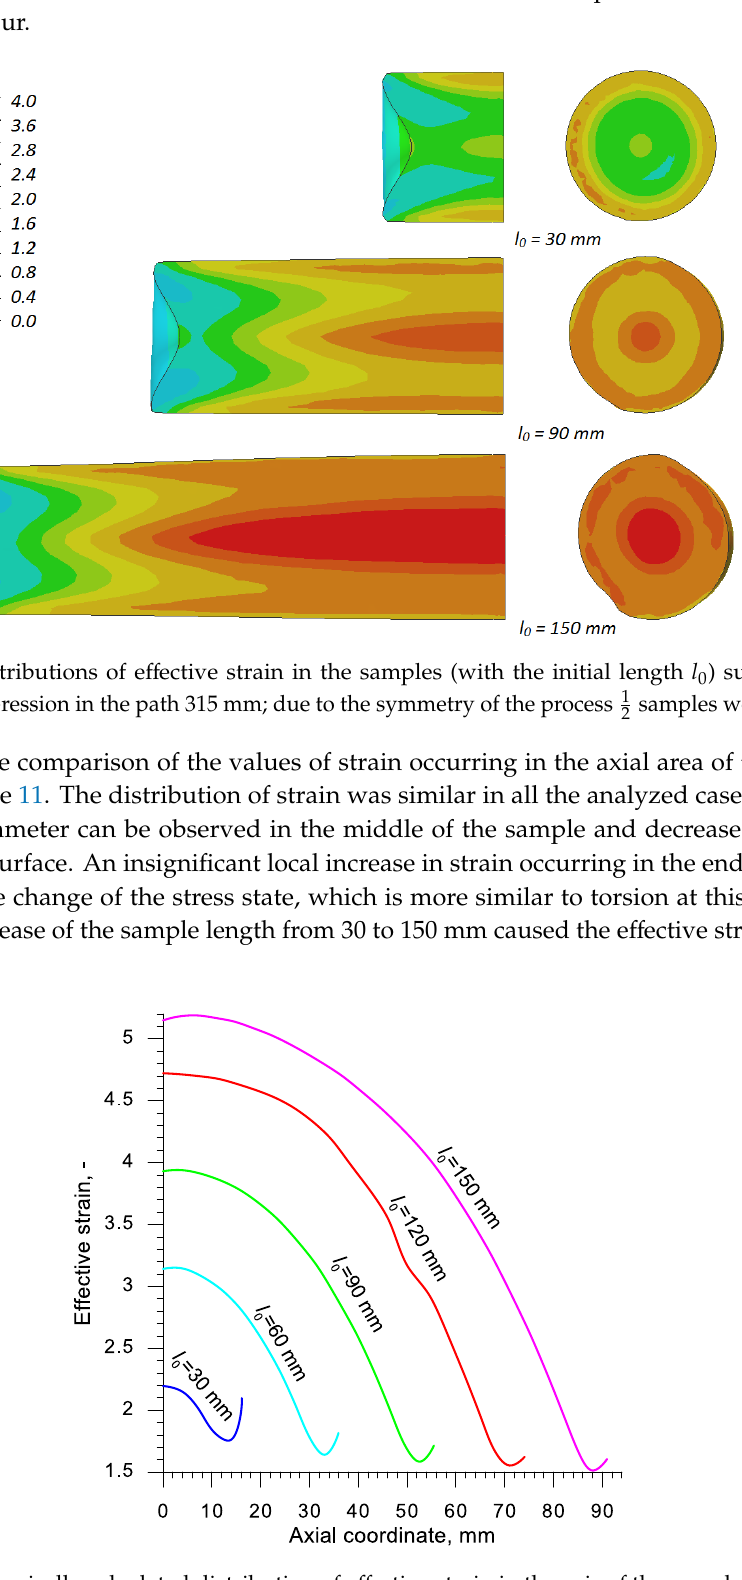
Figure 12. Distributions of temperature (w °C) in samples with the initial length l 0 , heated to T = 1150 °C and subjected to rotational compression in the path 315 mm; due to the symmetry of the process ½ samples was shown.